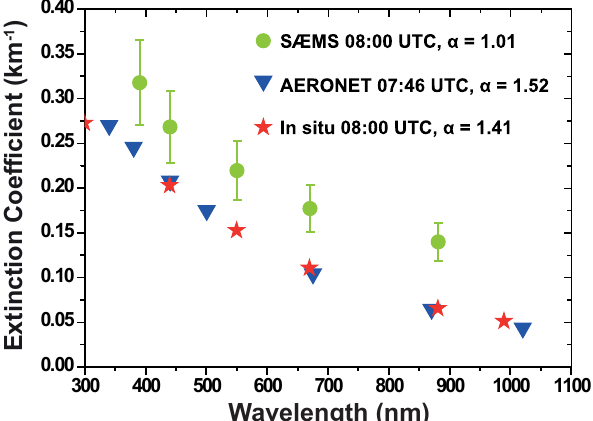
Fig. 10. Particle volume size distribution (d V/ dlog D p ) derived from SÆMS extinction spectra, from AERONET data (assuming a height of the tropospheric aerosol column of 3km), and from the in situ observations. Colors are the same as in Fig.